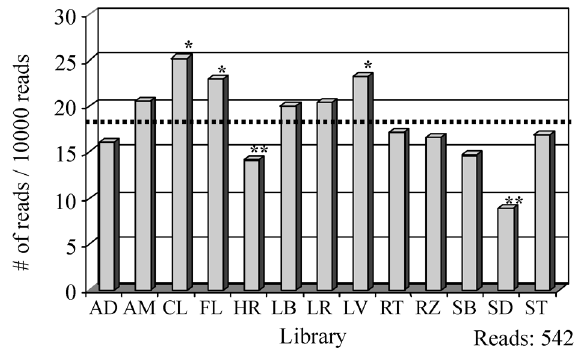
Figure 3 - Distribution of reads of the NER pathway. The dashed line rep- resents the average of reads observed in all tissues and those indicated by (*) or (**) are significantly different from the average (P < 0.01 as deter- mined by the T-test